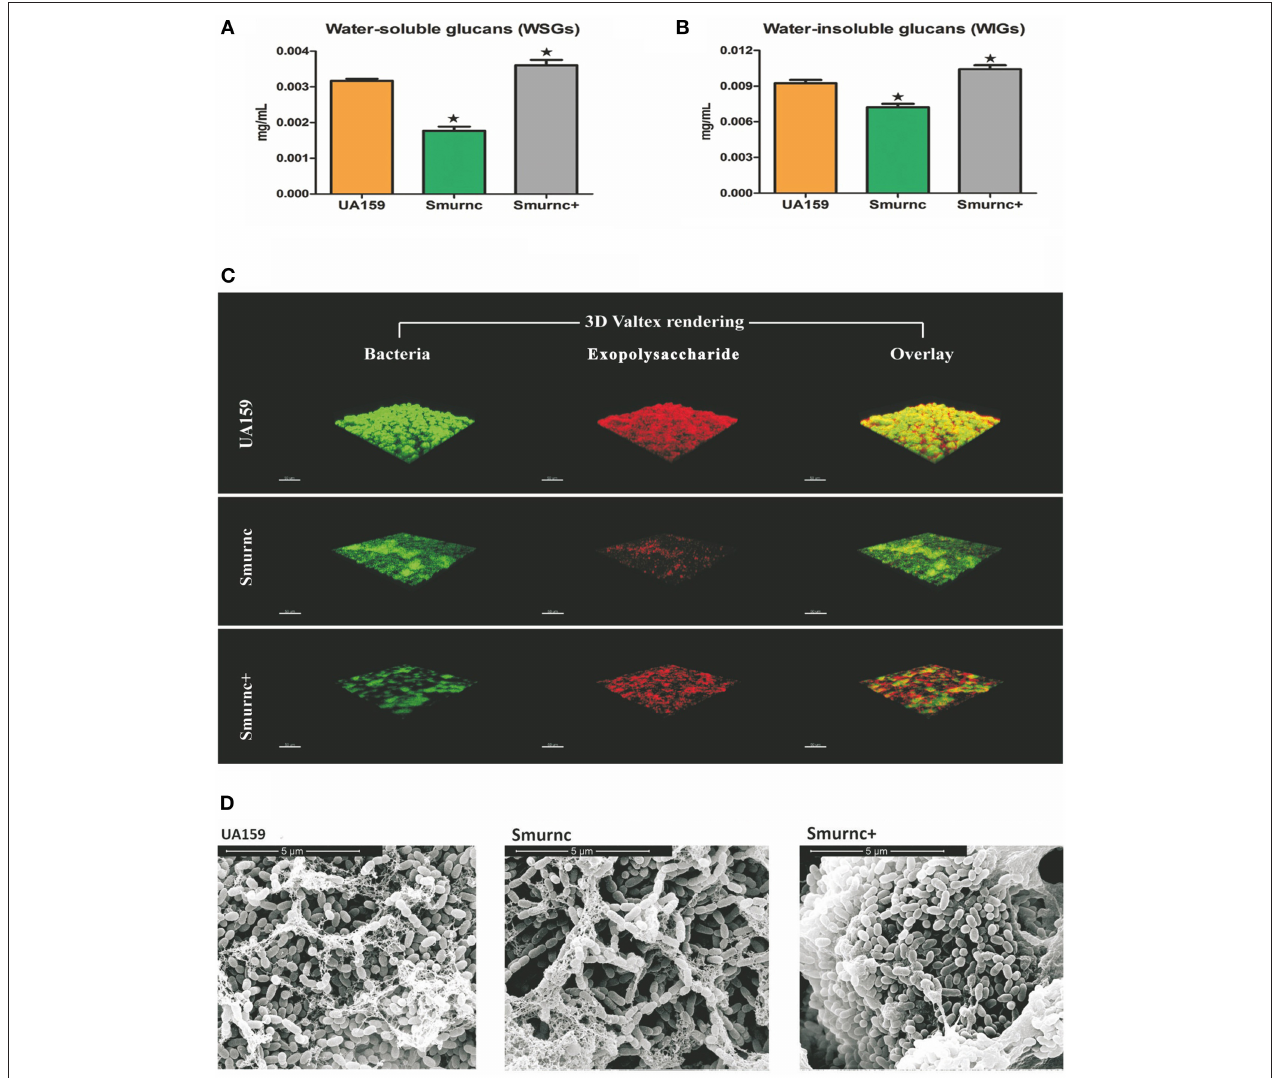
FIGURE 1 | The effects of rnc gene on exopolysaccharide synthesis and biofilm morphology in S. mutans . The anthrone assay was used to determine glucan productions in UA159, Smurnc, and Smurnc + biofilms at 24h. WSGs (A) and WIGs (B) were both calculated. The Smurnc strain decreased the amount of glucans, whereas the Smurnc + strain increased the amount. The error bars represent standard deviation values. Asterisks indicate significant differences ( P < 0.05 ). (C) Representative three-dimensional images of production and distribution of exopolysaccharide matrix in the biofilm architecture. Mature biofilms (24h) formed by S. mutans UA159 and rnc mutant strains in the presence of 1% (wt/vol) sucrose by CLSM. Images were taken at 63 × magnification. (D) SEM observation of the architecture of S. mutans mature biofilms (24 h). Images of biofilm structures formed by UA159 and rnc mutant strains were taken at 20,000 ×